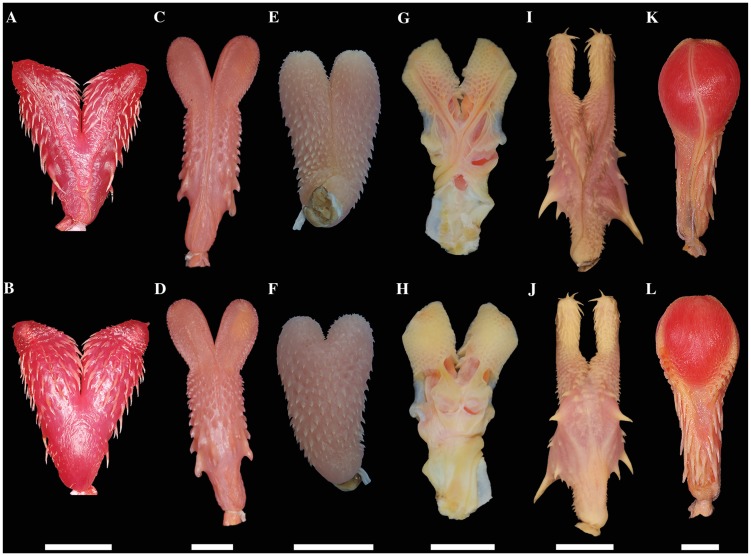
Hemipenes of Porthidum nasutum (A-B),
Brachyorrhos albus (C-D), Atractaspis
fallax (E-F), Oreocalamus hanitschi
(G-H), Grayia ornata (I-J), and Spilotes
sulphureus (K-L).A, C, E, G, I, K, sulcate views; B, D, F, H, J, L, asulcate views.
A-L completely everted and expanded. A-D, Scale bars = 5 mm; E-F,
scale bar = 10 mm; G-H, scale bar = 5 mm; I-J, Scale bars = 10
mm.